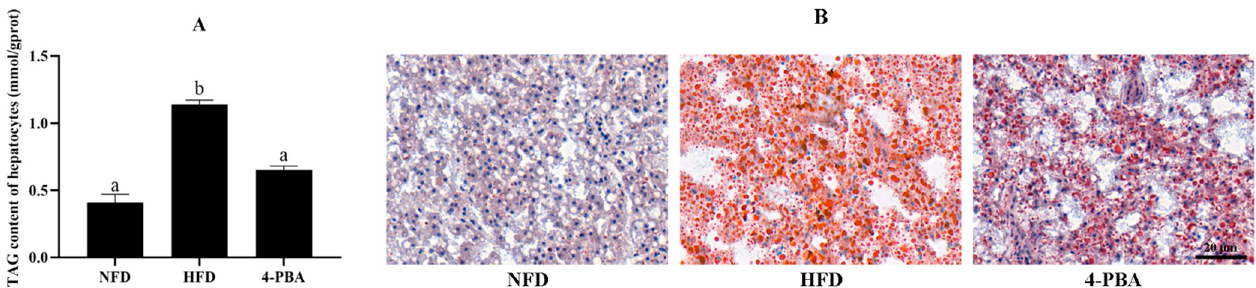
Figure 2. Hepatic TAG content ( A ) and oil red O-stained sections (( B ) scale bar = 20 µ m) of spotted seabass ( L. maculatus ) fed the test diets for eight weeks. All values are exhibited as mean ± SE. The values with different superscripts (a, b) are significantly different at p < 0.05 (Tukey’s test).